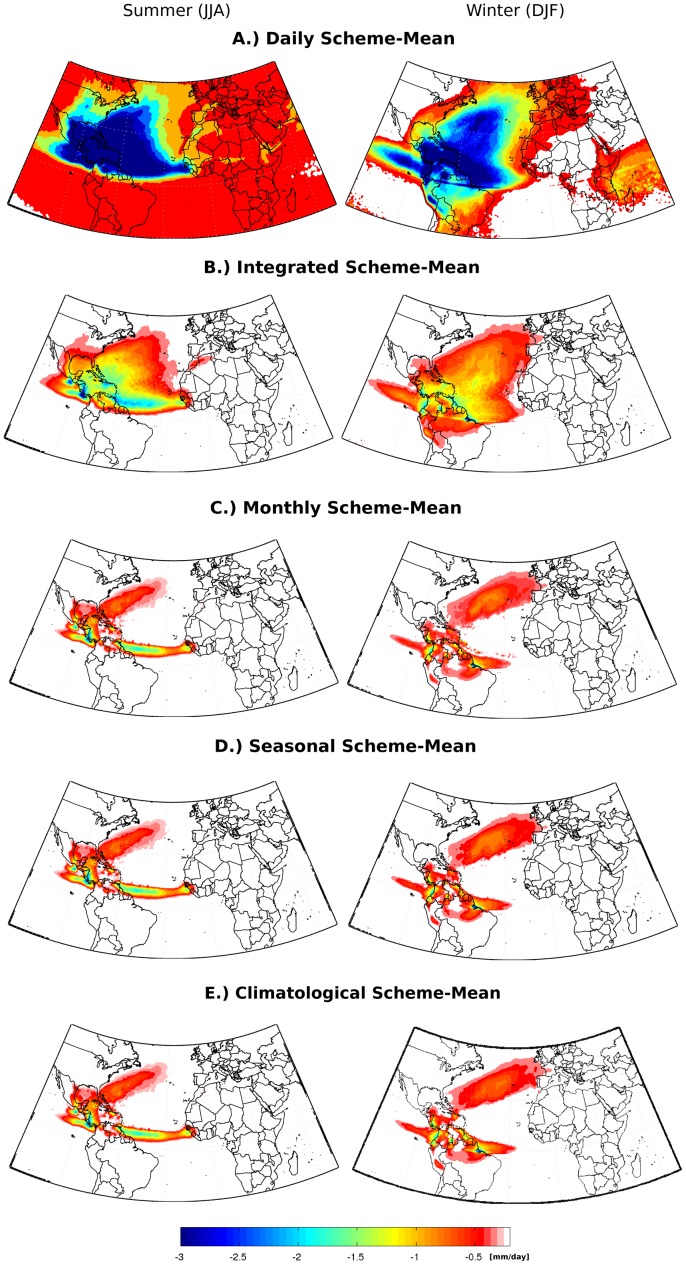
Summer (JJA) and winter (DJF) climatological seasonal net precipitation (E-P<0), from 1980 to 2000, estimated by integrating E-P over 10-day forward trajectories from the North Atlantic moisture source region, using the numerical approaches shown in
Figure 2
.